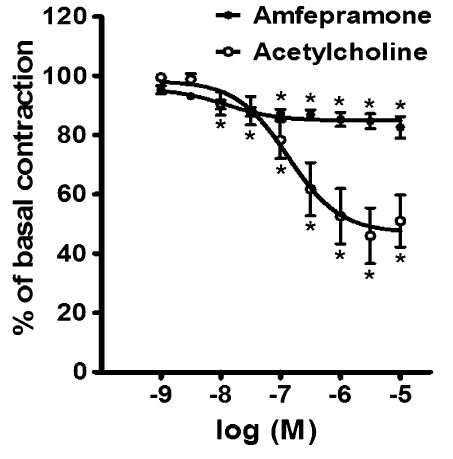
Figure 1. Concentration-dependent relaxation of 10 –9 -10 –5 M amfepramone (closed circles) and 10 –9 -10 –5 M acetylcholine (open circles) in rat aortic rings with intact endothelium. Data are reported as means±SE of n=6 observations. *P , 0.05 vs basal contraction (two-way